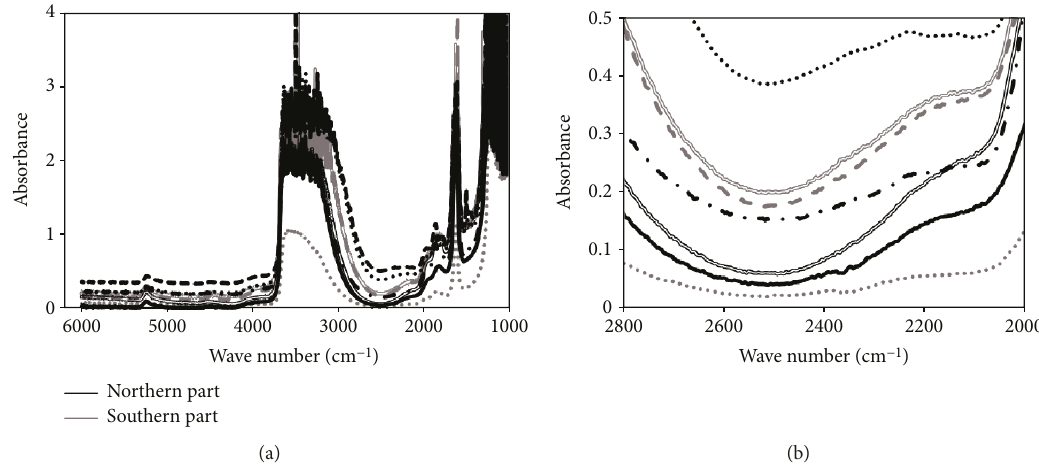
Figure 6: Water content and CO absorbance for the studied MIs. (a) Transmission FT – IR measurement results showing the spectrum of 2 each measurement for the MIs. The 5230 and 4500cm − 1 peaks were used to determine the water content of the MIs. (b) CO spectra show no evidence for CO in the 2